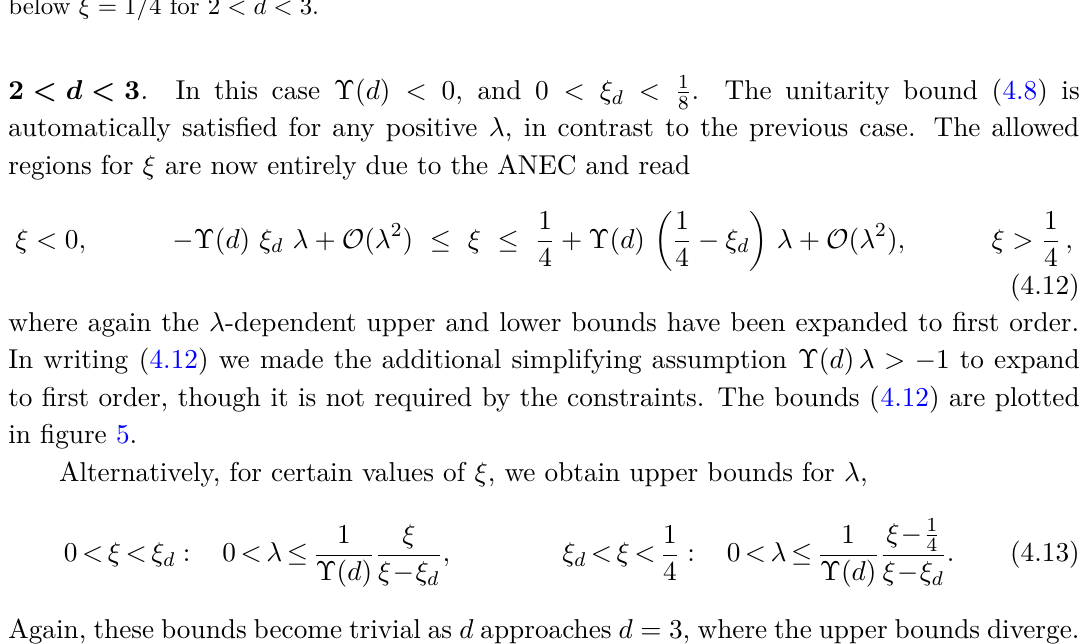
Figure 5 . The ANEC bounds exclude two ranges of ξ , in red zig-zag lines, abovew ξ = 0 and below ξ = 1 / 4 for 2 < d < 3